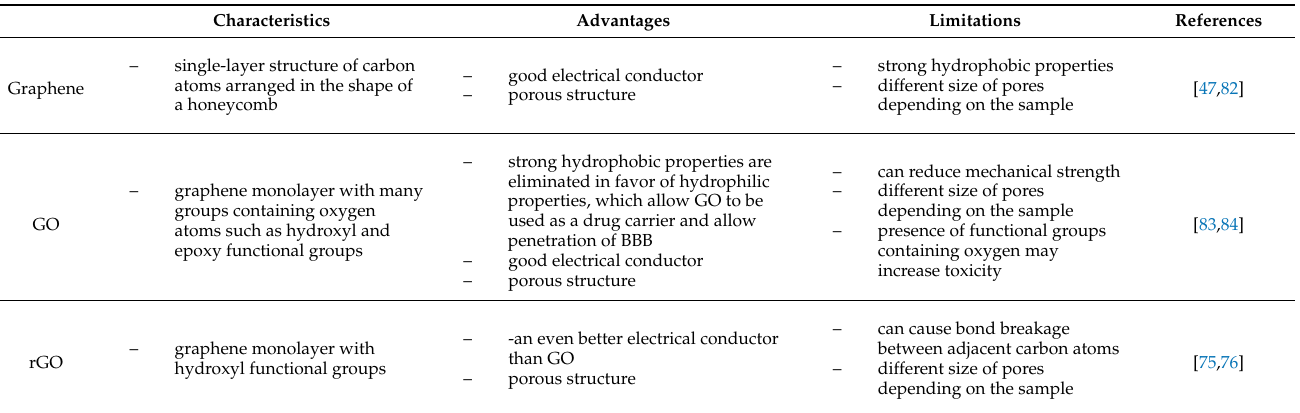
Table 7. Compilation of 2D graphene-based scaffolds.